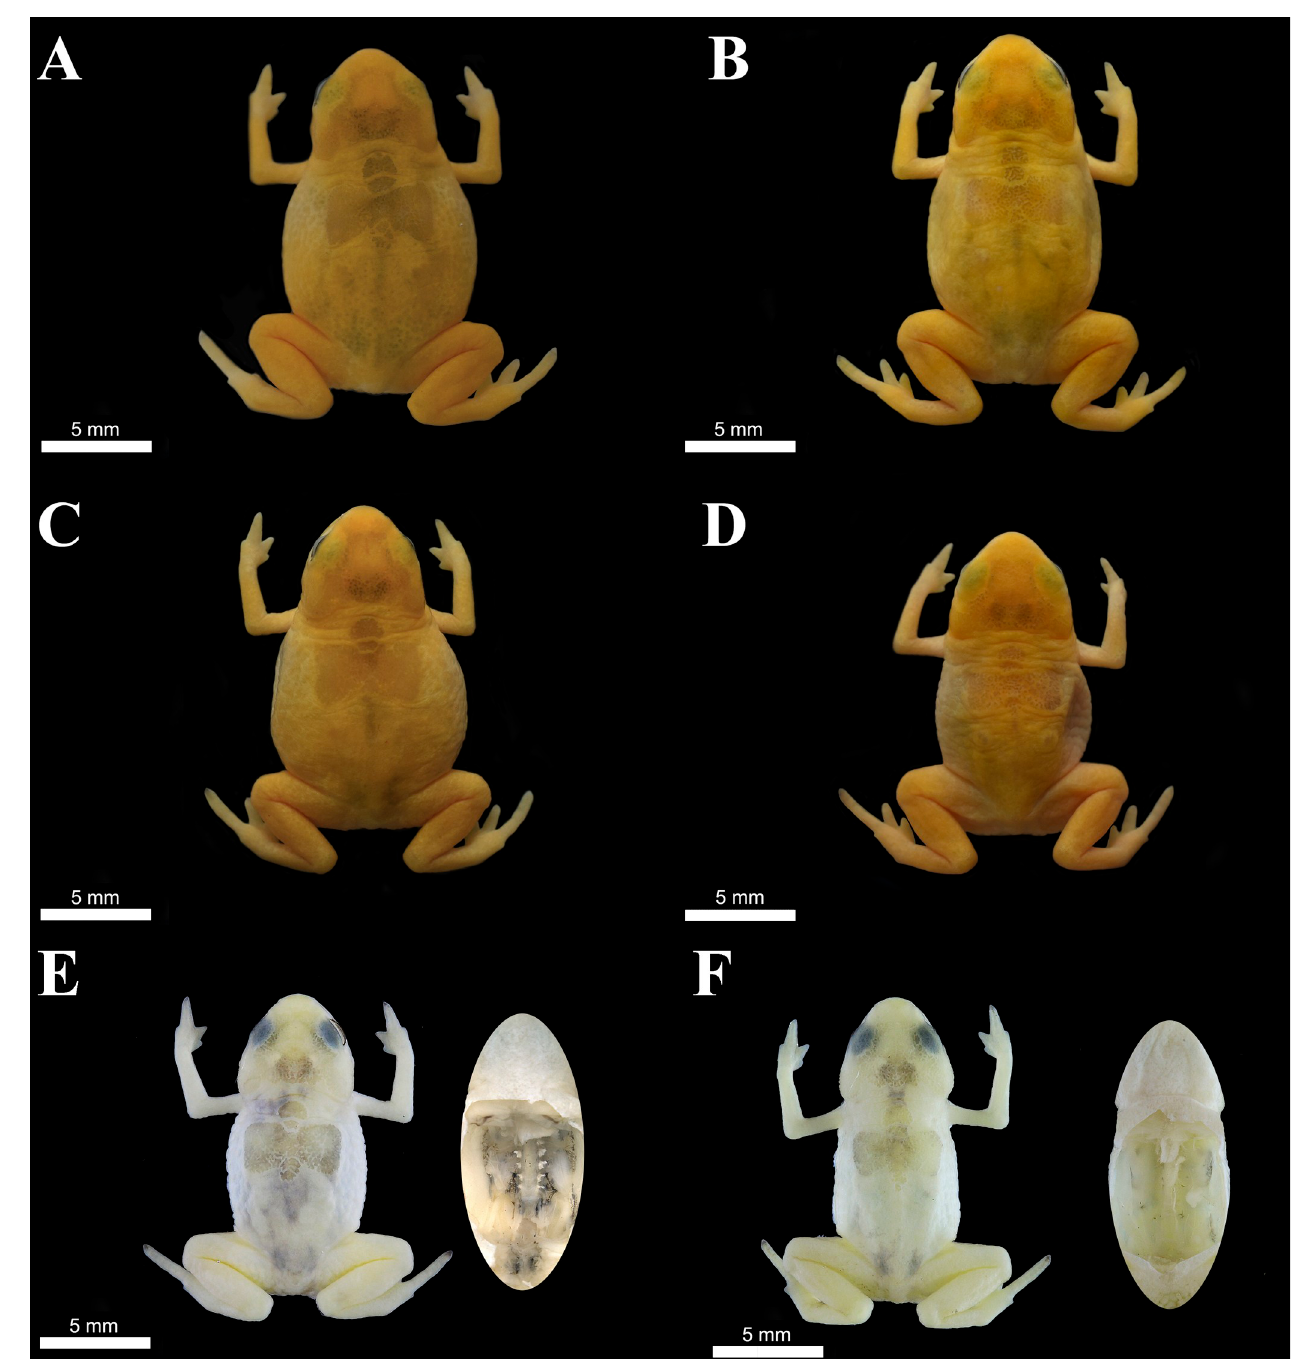
Fig 2. Variation in specimens of Brachycephalus rotenbergae sp. nov. regarding dorsal shield shape (A-D) and amount of black connective tissue (E-F). (A) HCLP-A 284 (adult female), (B) HCLP-A 285 (adult female), (C) HCLP-A 286 (adult female), (D) HCLP-A 287 (adult male), (E) ZUFMS-AMP 13648 (adult male), (F) ZUFMS-AMP 13649 (adult